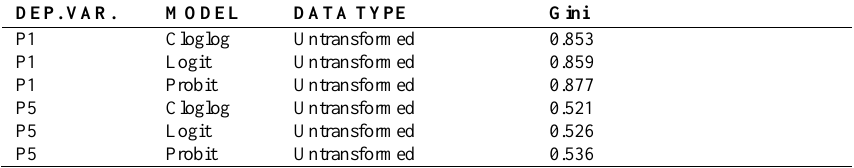
Table 4. Results for the Gini coefficient analysis for the individual assets analysis DEP.